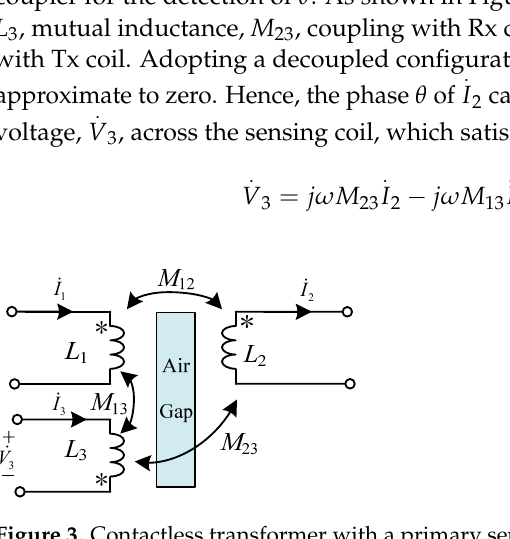
Figure 3. Contactless transformer with a primary sensing coil.